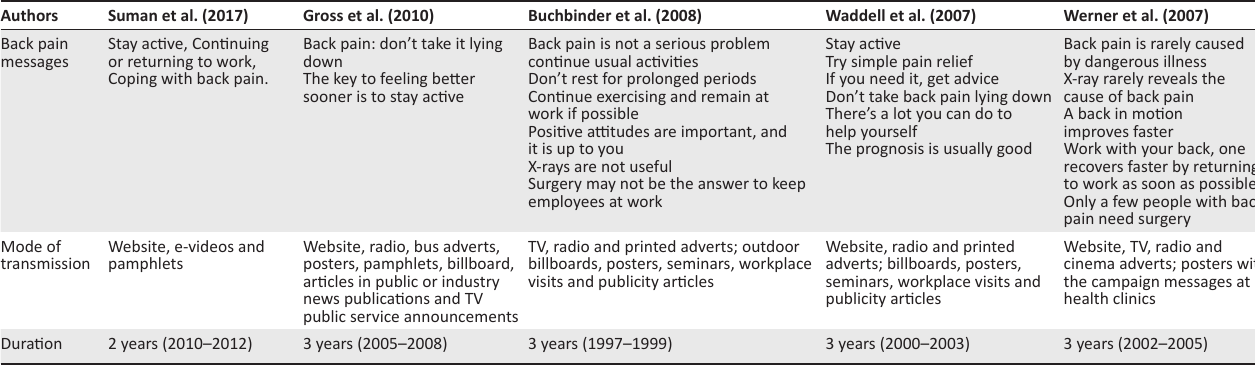
TABLE 4: Interventions, mode of transmission and duration.